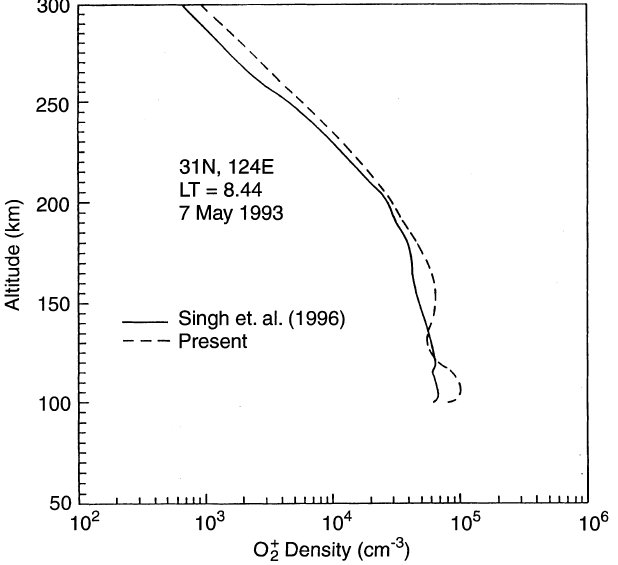
Fig. 2. Relative variation of O (cid:135) model and IRI-86 model